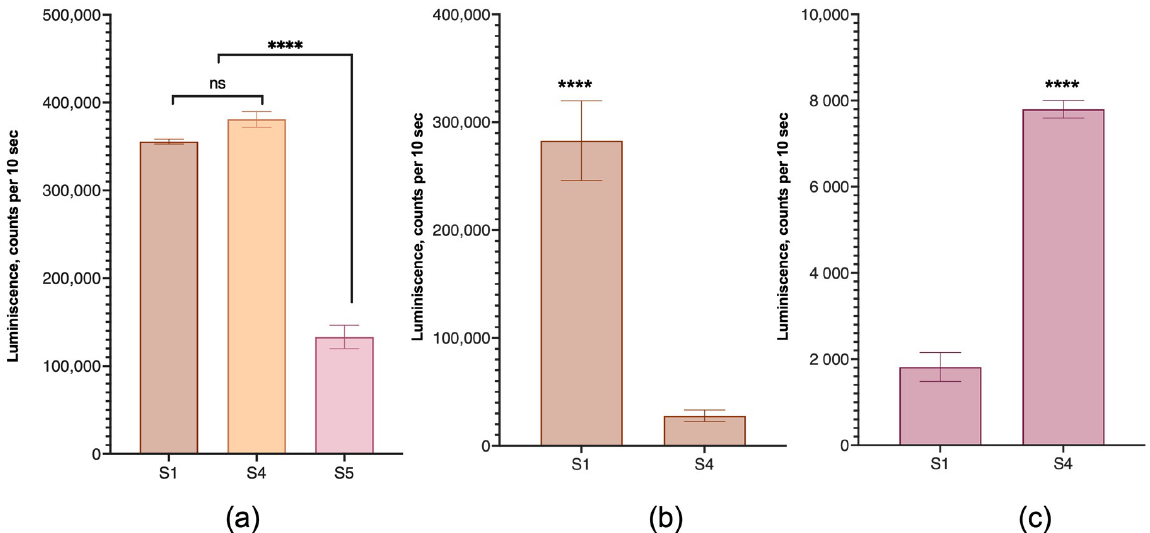
Figure 9. The efficiency of cell transfection with lipoplexes prepared from LNPs with different structural lipids. Phospholipid composition: 100% DOPE (sample S1), 100% DOPC (sample S4), and 50:50 DOPE/DOPC (sample S5). Incubation time was 24 h. ( a ) HEK 293T cells, ( b ) MDA-MB-231 cells, ( c ) SW 620 cells. The untreated controls did not differ from the background signal (700 counts per 10 s) and are not displayed. ****, A statistically significant difference, p < 0.0001, n = 3. ns, not significant.